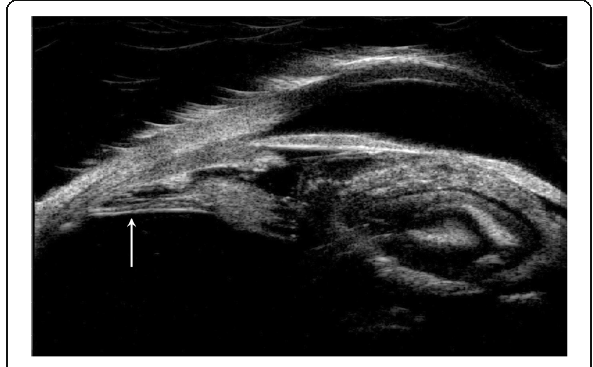
Fig. 1 Anterior extension of cyclitic membrane towards lens and ciliary body. 1772 × 1124 mm (72 × 72 DPI)